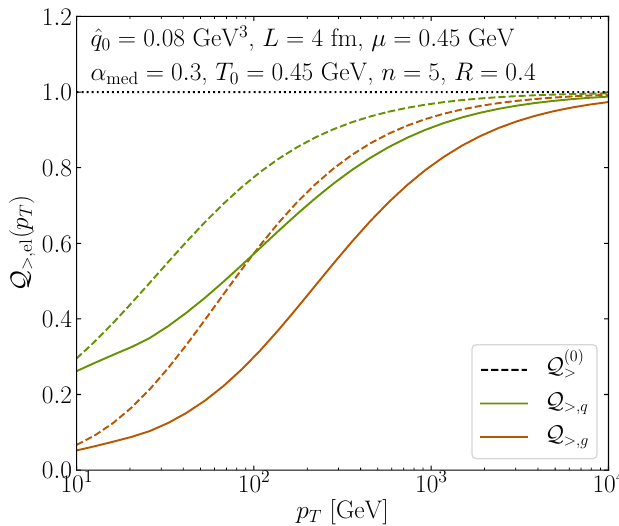
Figure 11 . The quenching factor of elastic scatterings from eq. (D.5) and with the collimator from eq.